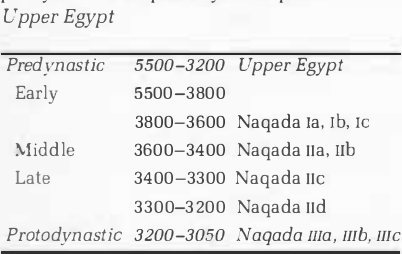
Table 1 Simplified chronology of the predynastic and protodynastic periods BC in Upp e r Egypt